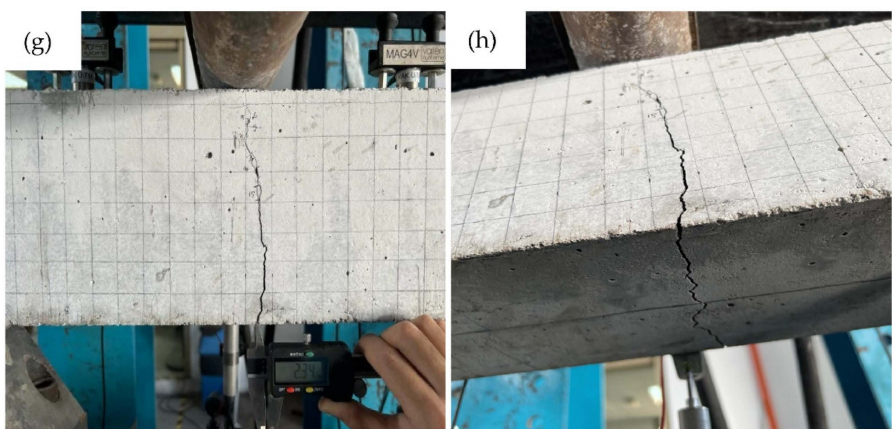
Figure 11. Crack pattern of the beam when subjected to cyclic loading at ( a ) first 100 cycles ( b ) 100 to 200 cycles ( c ) 300 to 400 cycles ( d ) 700 to 800 cycles ( e ) 1000 to 1200 cycles. ( f ) 1800 to 2000 cycles ( g ) 1800 to 2000 cycles ( h ) bottom part of the